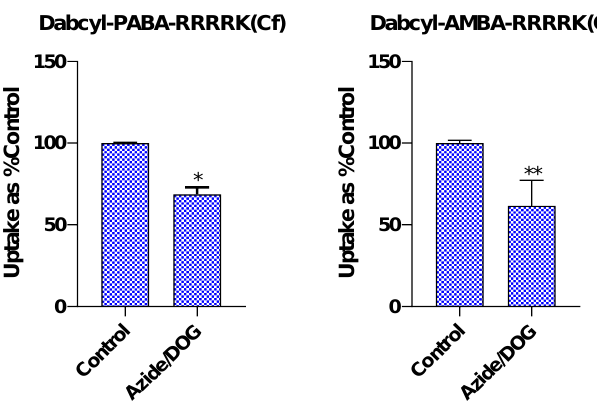
10 of 22 Figure 8. Effect of endocytosis inhibitors on the cellular uptake of peptide conjugates. MDA-MB- 231 cells were pretreated with inhibitors EIPA (50 µM), CPZ (30 µM), CyD (5 mM) and COL (20 µM) for 30 min, the cells were then treated with the peptide conjugates (5 µM) for 90 min. Significant difference from control w as measured using student’s t test (* p <0.05, ** p < 0.01and **** p < 0.0001). Treatment of peptides with EIPA showed a contrasting effect for peptides. While it decreased the uptake of Dabcyl-AMBA-RRRRK, it did not alter the internalization of Dabcyl-PABA-RRRRK. CPZ, a clathrin-mediated endocytosis inhibitor, and COL, a mi- crotubule inhibitor, did not cause any inhibition. The most significant change was caused